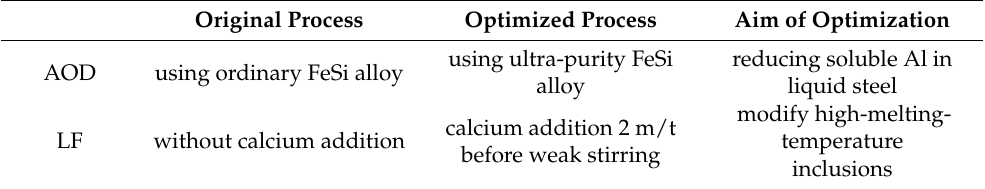
Table 10. Process optimization scheme for low-melting-point silicate inclusions control. Original